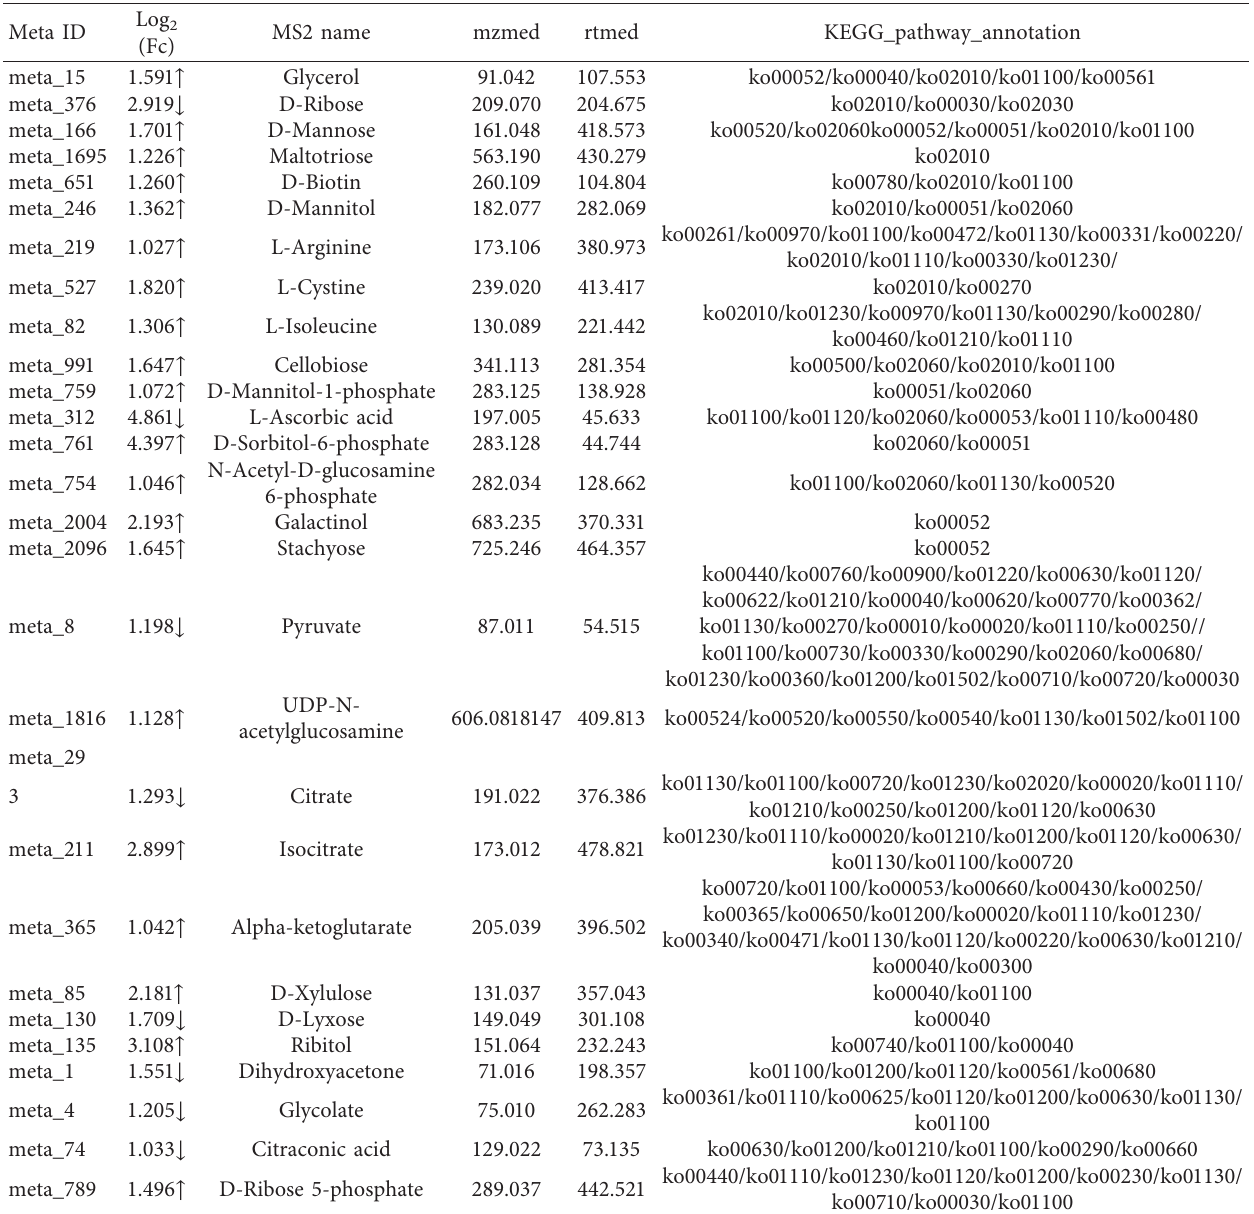
Table 3: Metabolites involved in related carbohydrate transport and metabolism in the KEGG pathway during the growth of B. adolescentis on X5 compared to X2/X3 assessed by